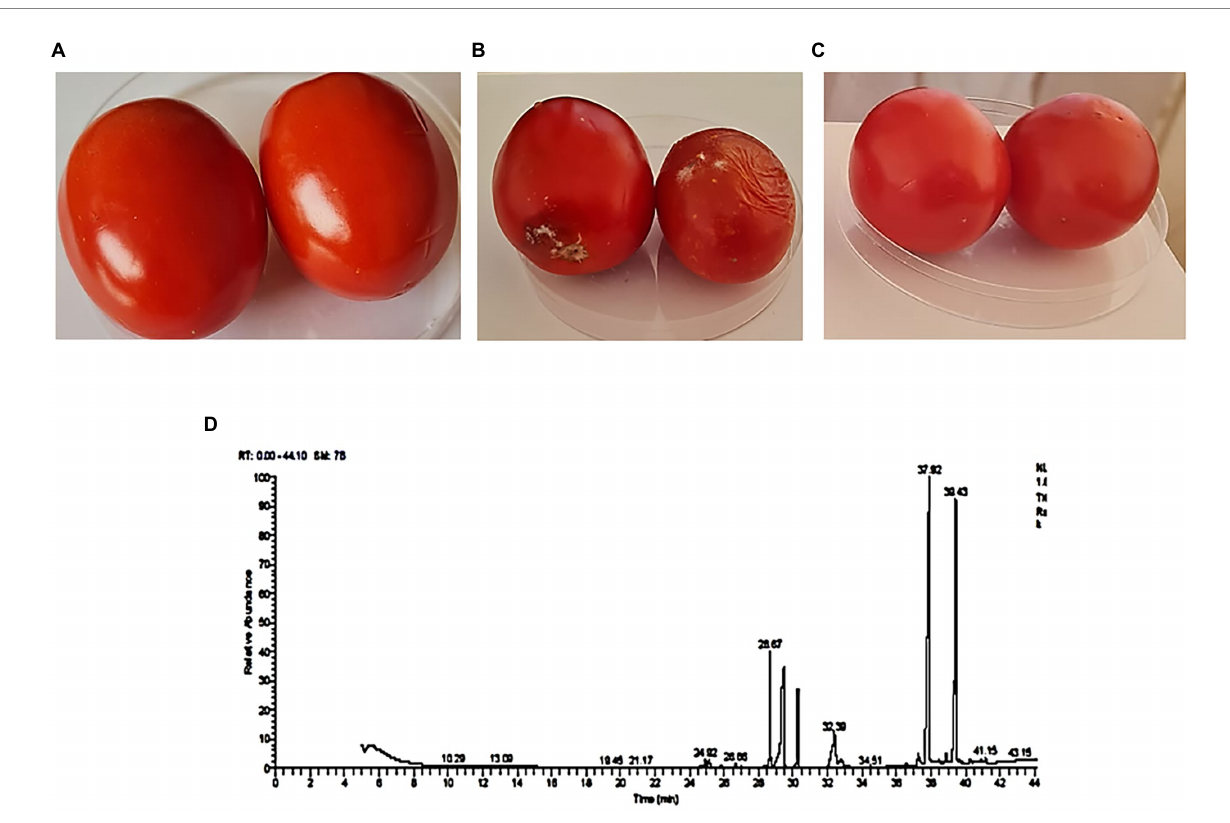
FIGURE 8 Biocontrol efficacy of T. asperellum crude extract against F. oxysprum . (A) Tomato fruit inoculated with T. asperellum extract. (B) Tomato fruit inoculated with a spore suspension of F. oxysporum only . (C) Tomato fruit inoculated with T. asperellum extract and F. oxysporum . (D) The fraction of bioactive secondary metabolites were detected using a GC–MS chromatogram obtained from T.